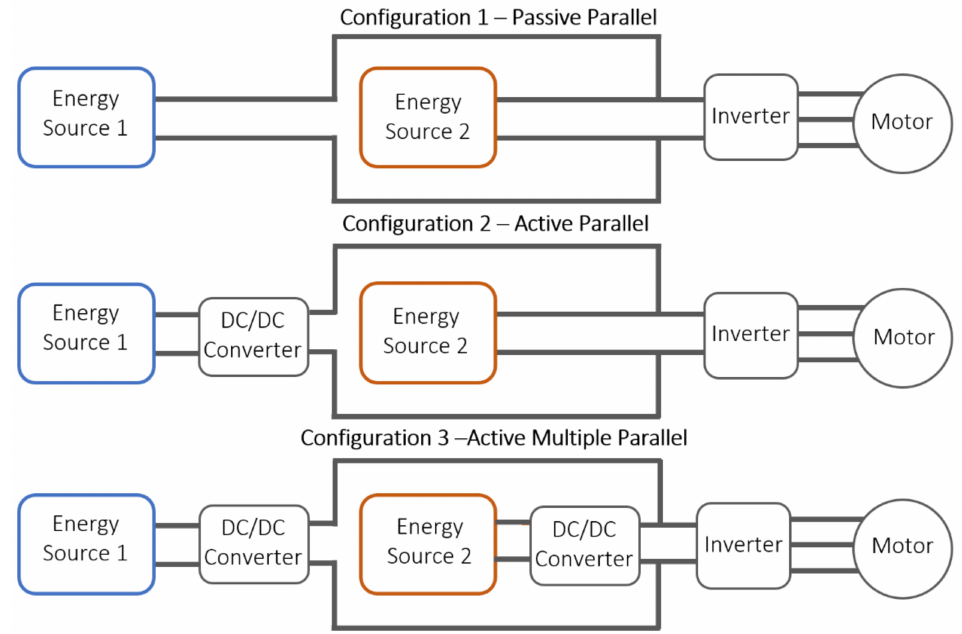
Figure 2. Three main active topologies for hybrid energy storage